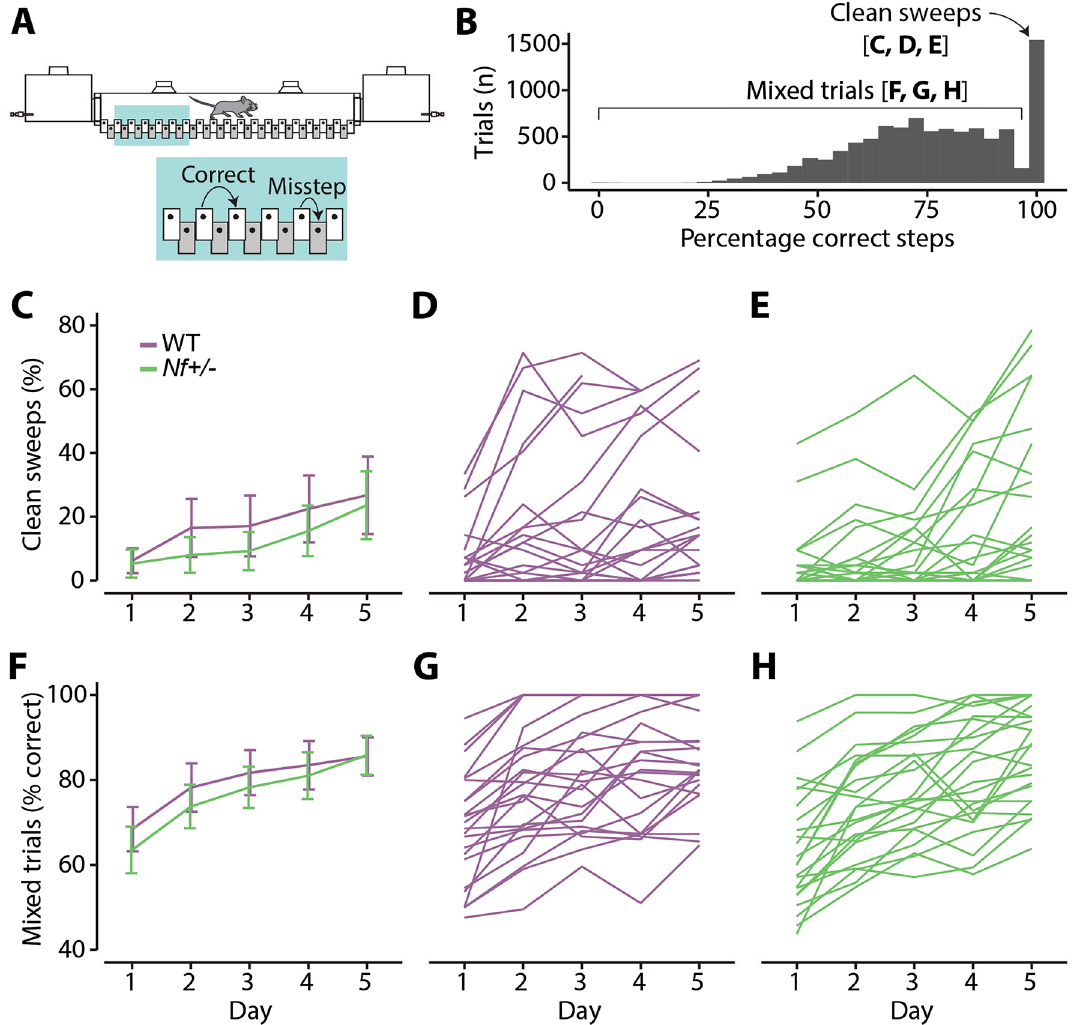
Figure 4. ErasmusLadder performance. ( A ) Schematic of the ErasmusLadder task. Correct steps are defined as a step from a high beam to any high beam further towards the end of the ladder. Missteps are defined as any step involving a low beam. ( B ) Histogram of the percentage of correct steps per trial. There is a large number of trials that have 100% correct steps, the so-called clean sweeps. The other trials are called mixed trials. ( C ) Lines represent the mean of the individual median proportion of clean sweeps, with whiskers being the 95% CI. In ( D ) and ( E ) each line represents the median proportion of clean sweeps of an individual mouse. ( F ) Lines represent the means of the individual median proportion of correct steps within mixed trials, with whiskers being the 95% CI. In ( G ) and ( H ) each line represents the median proportion of correct steps within mixed trials of an individual